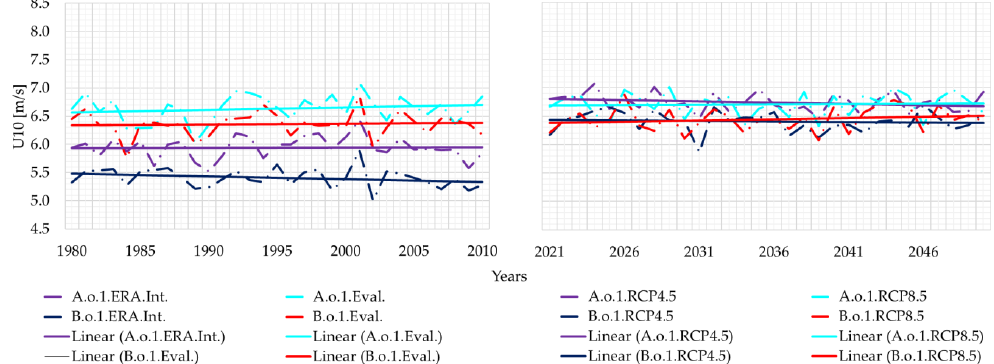
Figure 4. Annual averages of the wind speed at 10 m height for two of the most representative points located in the Bulgarian nearshore. ERA.Int and Eval data, time interval 1981–2010, RCP4.5 and RCP8.5 data, time interval 2021–2050.